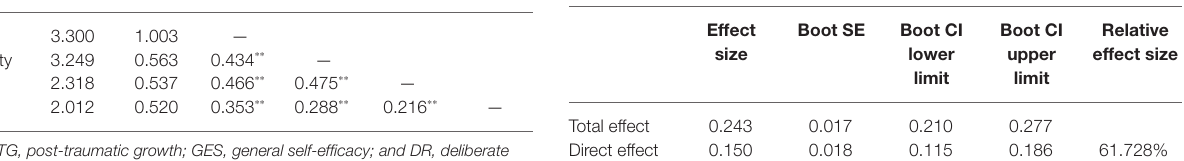
TABLE 3 | Total effect, direct effect and indirect effect among the